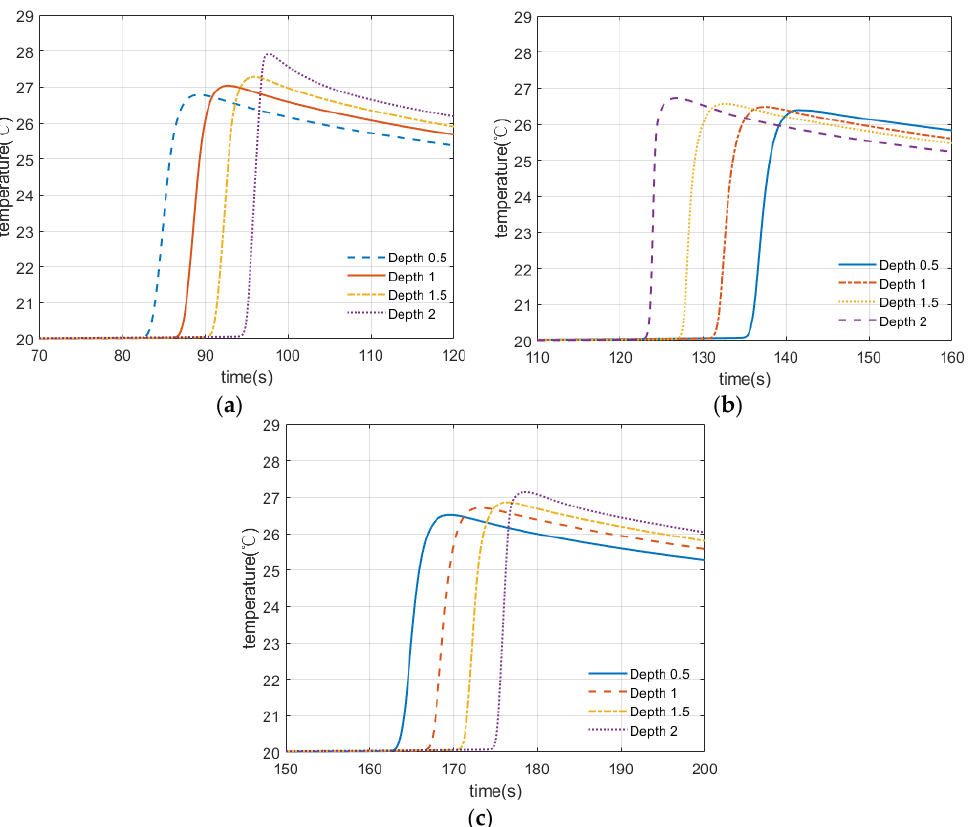
Figure 7. Temperature response of damage in different directions. ( a ) 0 ° crack temperature response curve, ( b ) 90 ° crack temperature response curve and ( c ) 45 ° crack temperature response curve.